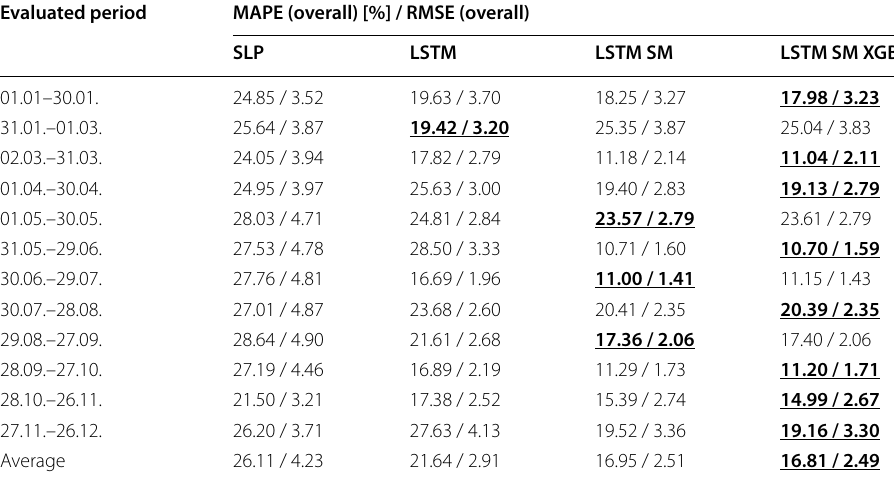
Best values in respective rows highlighted in bold font and underlined